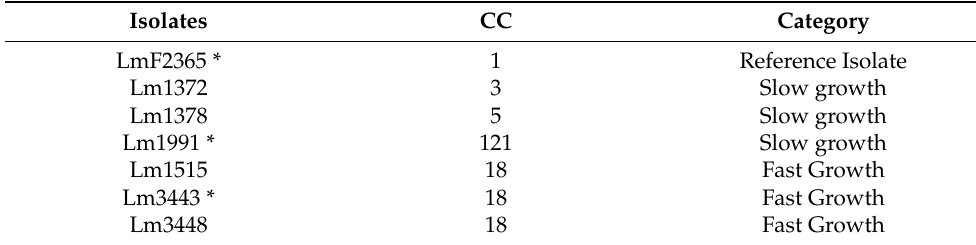
Table 2. Isolates selected for detailed growth rate experiments in media and food